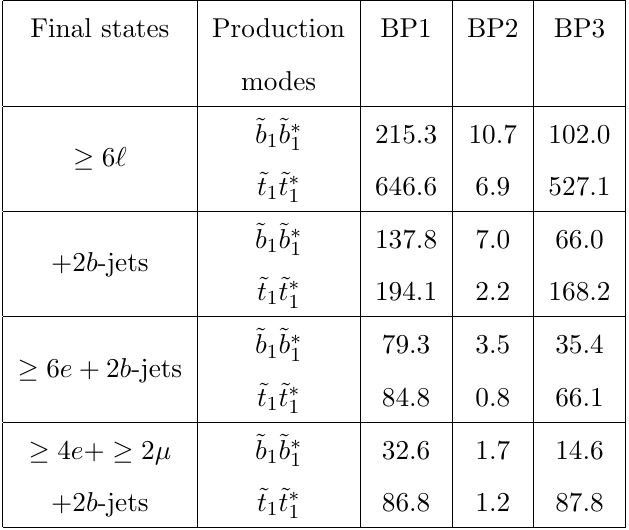
Table 6. Final state numbers for the benchmark points at 100 fb (cid:0) 1 at the LHC with 14 TeV, where the contributions are from ~ b 1 ~ b (cid:3) and ~ t 1 ~ t (cid:3) respectively. 1 1 4 e + 2 (cid:22) (cid:12)nal states. The (cid:12)nal states are almost background free specially with the (cid:21) (cid:21) displaced charged electrons. For 6 ‘ (cid:12)nal state (cid:12)nal state gets signal signi(cid:12)cance of 29.4 (cid:27) , (cid:21) 4.2 (cid:27) , and 25.1 (cid:27) respectively for BP1, BP2 and BP3 for center of mass energy of 14 TeV at the LHC at an integrated luminosity of 100 fb (cid:0) 1 . The required luminosity for 5 (cid:27) signi(cid:12)cance can vary from few fb (cid:0) 1 to (200) fb (cid:0) 1 . 6 ‘ +2 b -jets (cid:12)nal state signal signi(cid:12)cance numbers O (cid:21) are 12.8 (cid:27) , 2.1 (cid:27) , and 10.1 (cid:27) respectively for BP1, BP2 and BP3 for center of mass energy